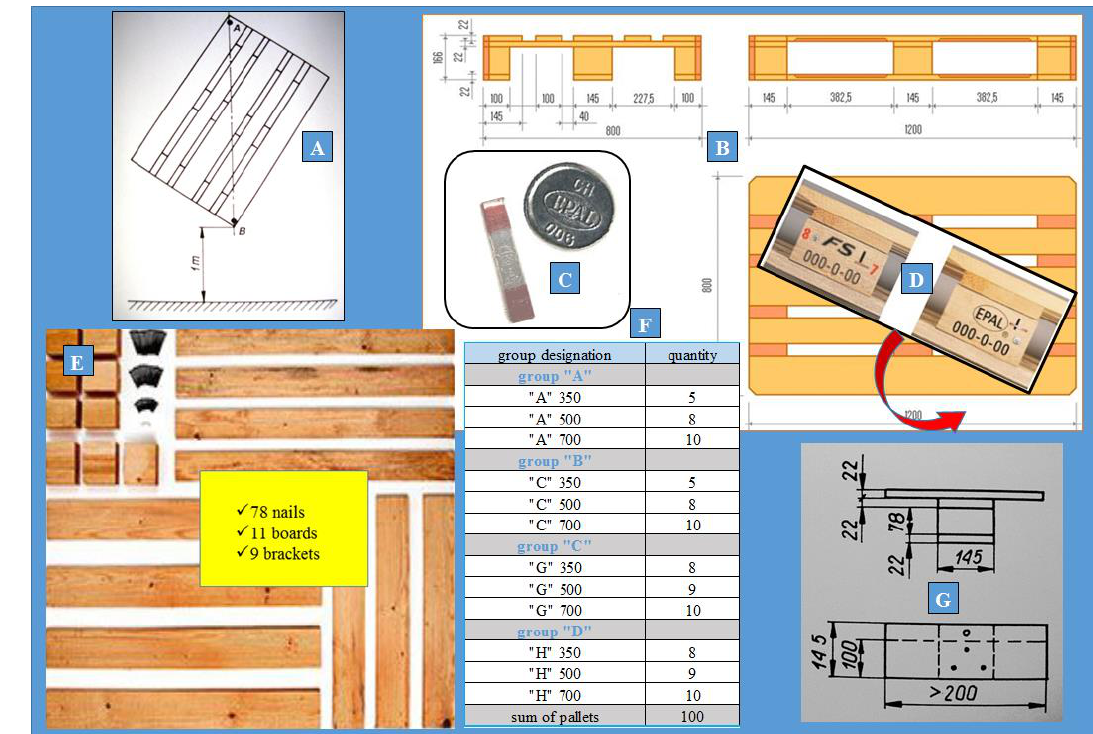
Figure 15. Illustration of the conducted tests: ( A )—Checking the resistance of the pallet to free fall; ( B )—Checking the dimensions of the pallet; ( C )—Check: new pallet inspection staples/pallet repair authenticity nail nail; ( D )—Checking the mandatory inscriptions on the pallet (railway management, manufacturer, hygienic approvals); ( E )—Checking the required structural elements of the pallet; ( F )—List of pallet research slot; ( G )—Illustration of a connection durability test of pallet structural elements (6 – 10 Nm).